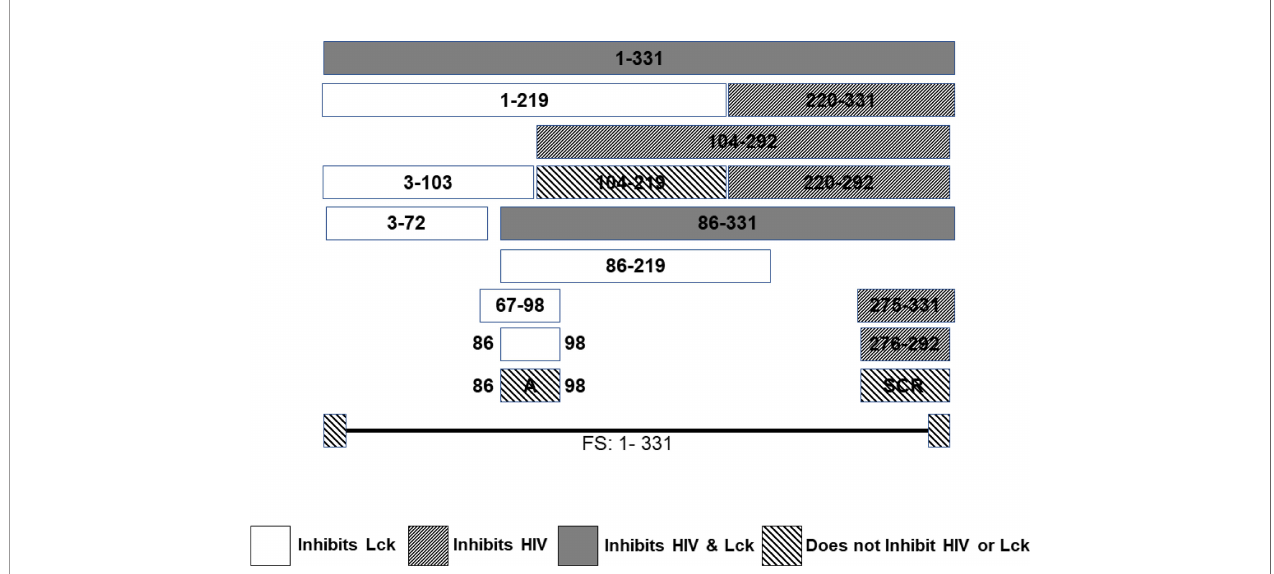
FIGURE 4 | HPgV E2 protein has two discrete regions that interfere with either HIV replication or T cell activation adapted from References (121, 164). Schematic representation of the regions of E2 protein expressed by stably transfected CD4+ T cells that either inhibit HIV replication or blunts T cell receptor (TCR) signaling. HPgV E2 regions that both inhibited HIV and TCR signaling are shaded. Those that only interfere with TCR are white. E2 regions inhibiting HIV replication have narrow, forward slash shading, while regions that did not interfere with either HIV replication or TCR signaling are wide, backslash shaded. Full-length HPgV E2 protein with the C terminal transmembrane domain deleted (331 amino acids) is shown on top, and deletion proteins below. Scrambling the order of the 17 amino acids interfering with HIV replication abolished HIV inhibition. Mutation of a tyrosine in the TCR inhibitory peptide to an alanine abolished TCR inhibition. FS represents the full-length RNA for E2 in which a frame shift insertion was created to abolish E2 protein